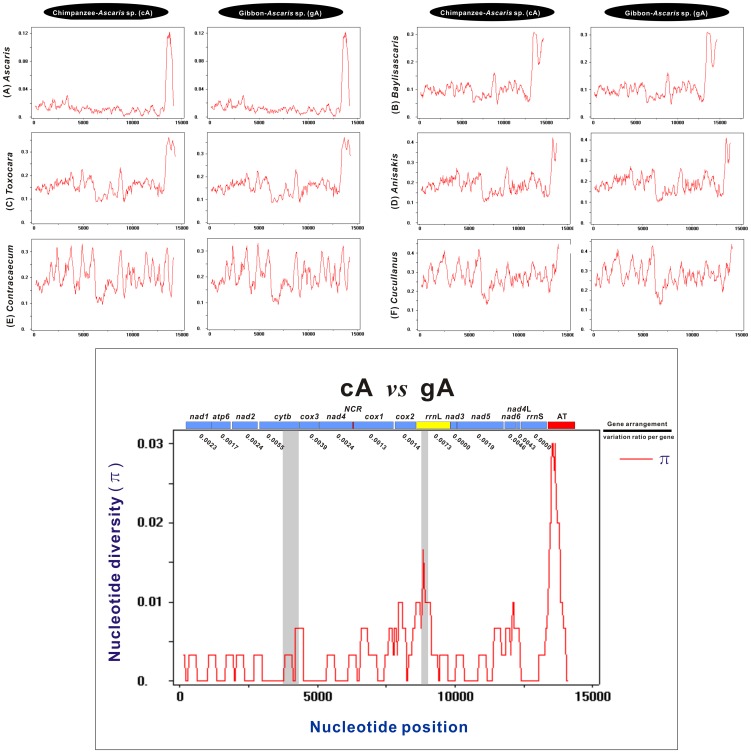
Sliding window analysis of alignments of complete mtDNAs of sequenced ascaridoid species from different genera.Sliding window analysis was separately employed to determine the nucleotide alignments of the complete mt genomes between the chimpanzee Ascaris (cA) or gibbon Ascaris (gA) and other genera. Nematodes of six genera (i.e., Ascaris, Baylisascaris, Toxocara, Anisakis, Contracaecum, and Cucullanus) were analyzed. The red line indicates the value of nucleotide diversity Pi (π) in a sliding window of 300 bp with a step size of 30, and the value is inserted at its mid-point. Each gene boundary coupled with a variation ratio per gene is indicated only in the plot of the nucleotide diversity between cA and gA. Gene regions used previously by Xie et al. (2011) are also denoted by shaded columns in this plot.